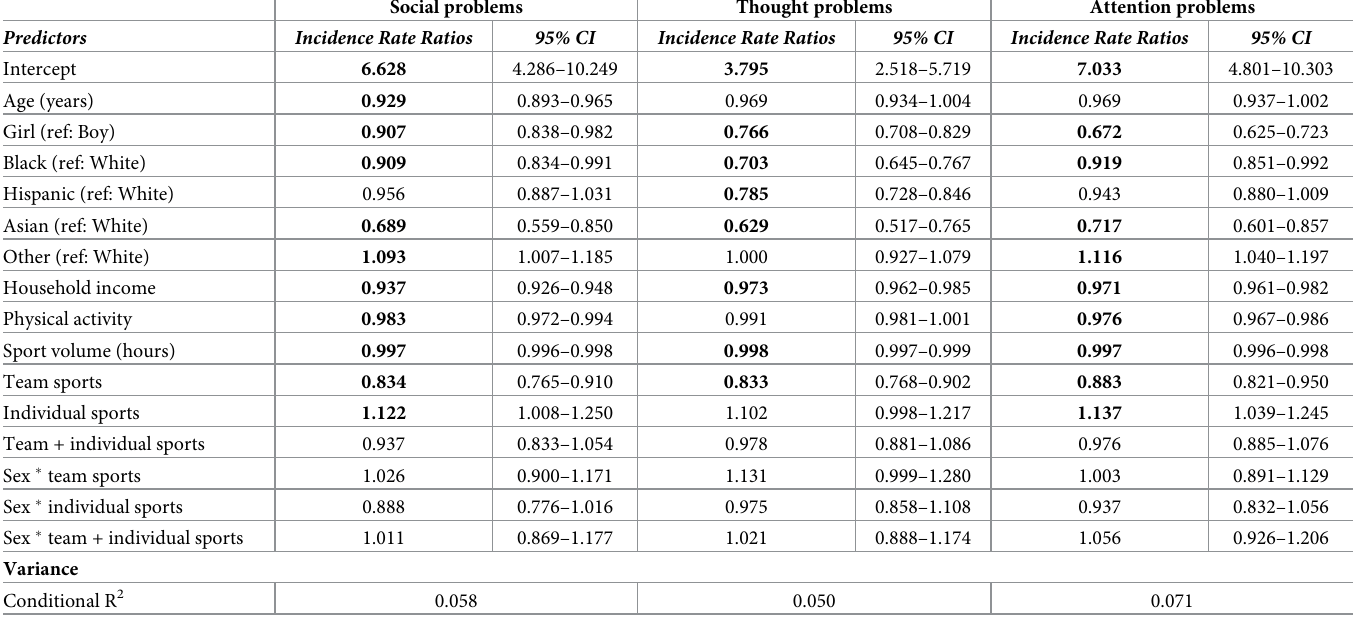
Table 4. Associations between types of sport participation and mental health